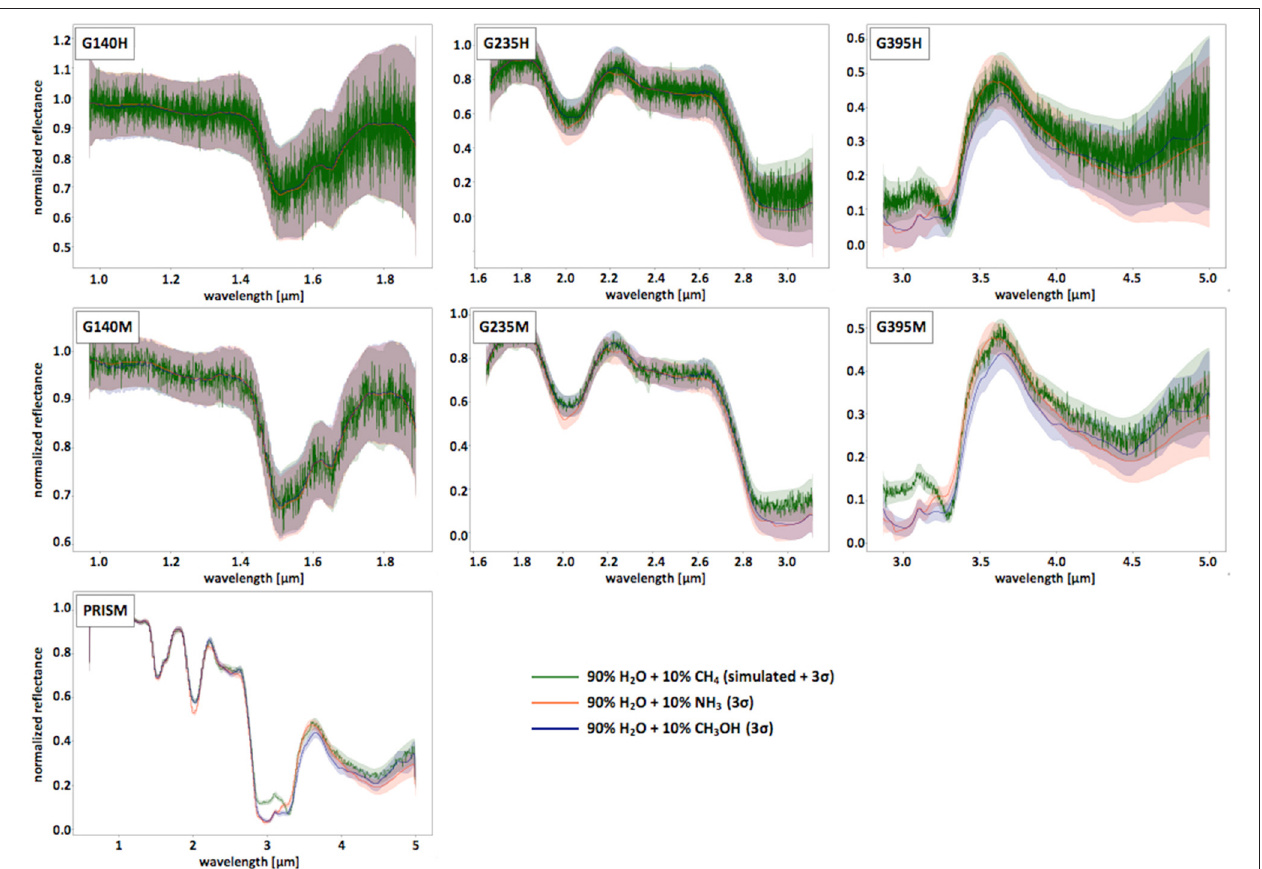
FIGURE 4 | Simulated spectra for mixtures of 90% water ice with 10% of methane, ammonia, and methanol ice, shown (from top to bottom) for the high-, medium- and low-spectral resolution elements, respectively. The simulated signal is shown for one mixture for clarity. Shaded areas show the 3- σ detection limits corresponding to the simulated signal-to-noise ratios. Exposure time and other relevant instrumental features may be found in Table 2